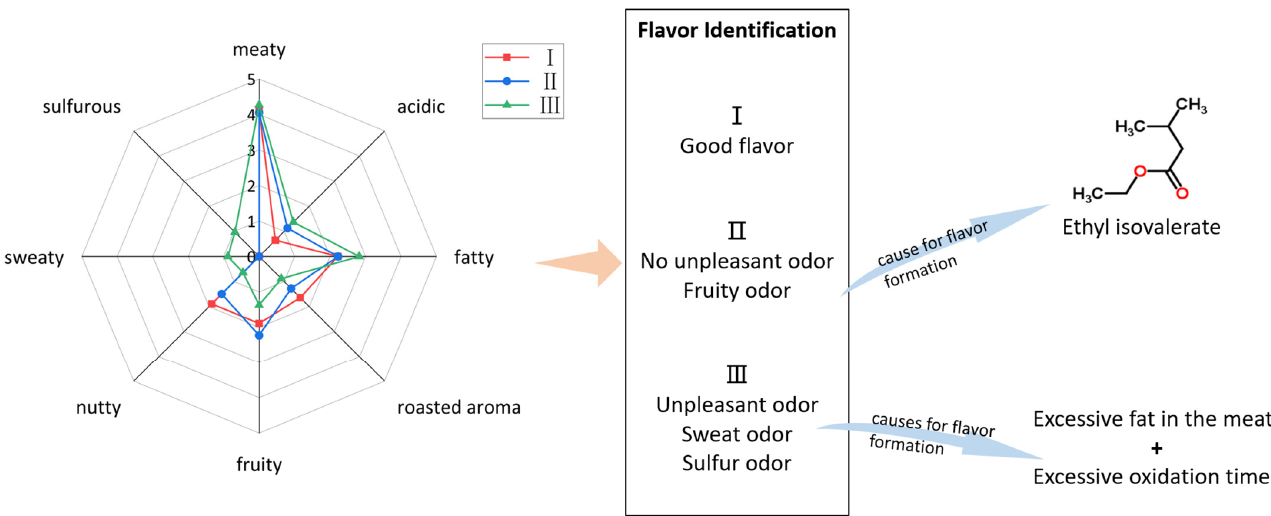
Figure 4. Flavor grade identification chart of Jinhua ham.